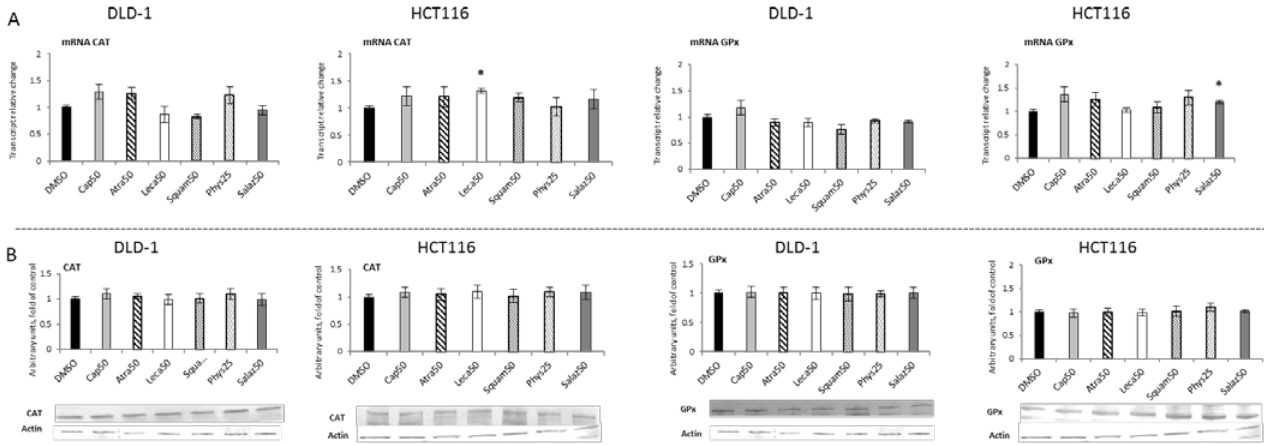
Figure 5. The effect of lichen-derived compounds on the expression of selected Nrf2 target genes: CAT and GPx in DLD-1 and HCT116 cells. ( A ) Levels of CAT and GPx transcripts. The values (fold of control) are presented as the means ± SEM from three separate experiments. ( B ) Levels of CAT and GPx proteins. Representative Western immunoblots are presented under the graphs. Results (mean s ± SEM from three separate experiments) are presented as a fold change to control after normalization against the level of actin. Asterisks (*) denote statistically significant changes from the control group ( p ≤ 0.05). DMSO , vehicle control; Cap50 , caperatic acid (50 µM); Atra50 , atranorin (50 µM); Leca50 , lecanoric acid (50 µM); Squam50 , squamatic acid (50 µM); Phys25 , physodic acid (25 µM); Salaz50 , salazinic acid (50 µM).